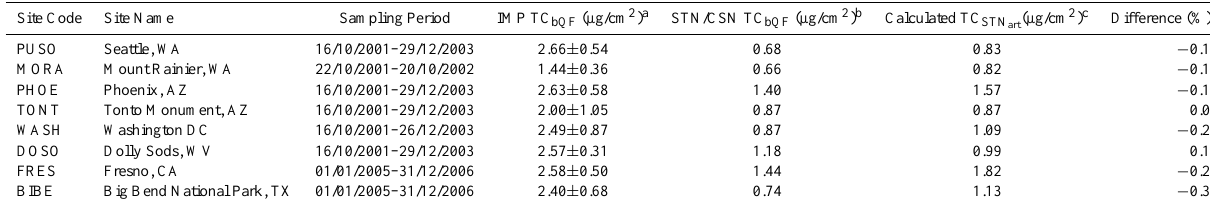
Table 6. Comparison between calculated and measured sampling artifact for the eight collocated IMPROVE/STN